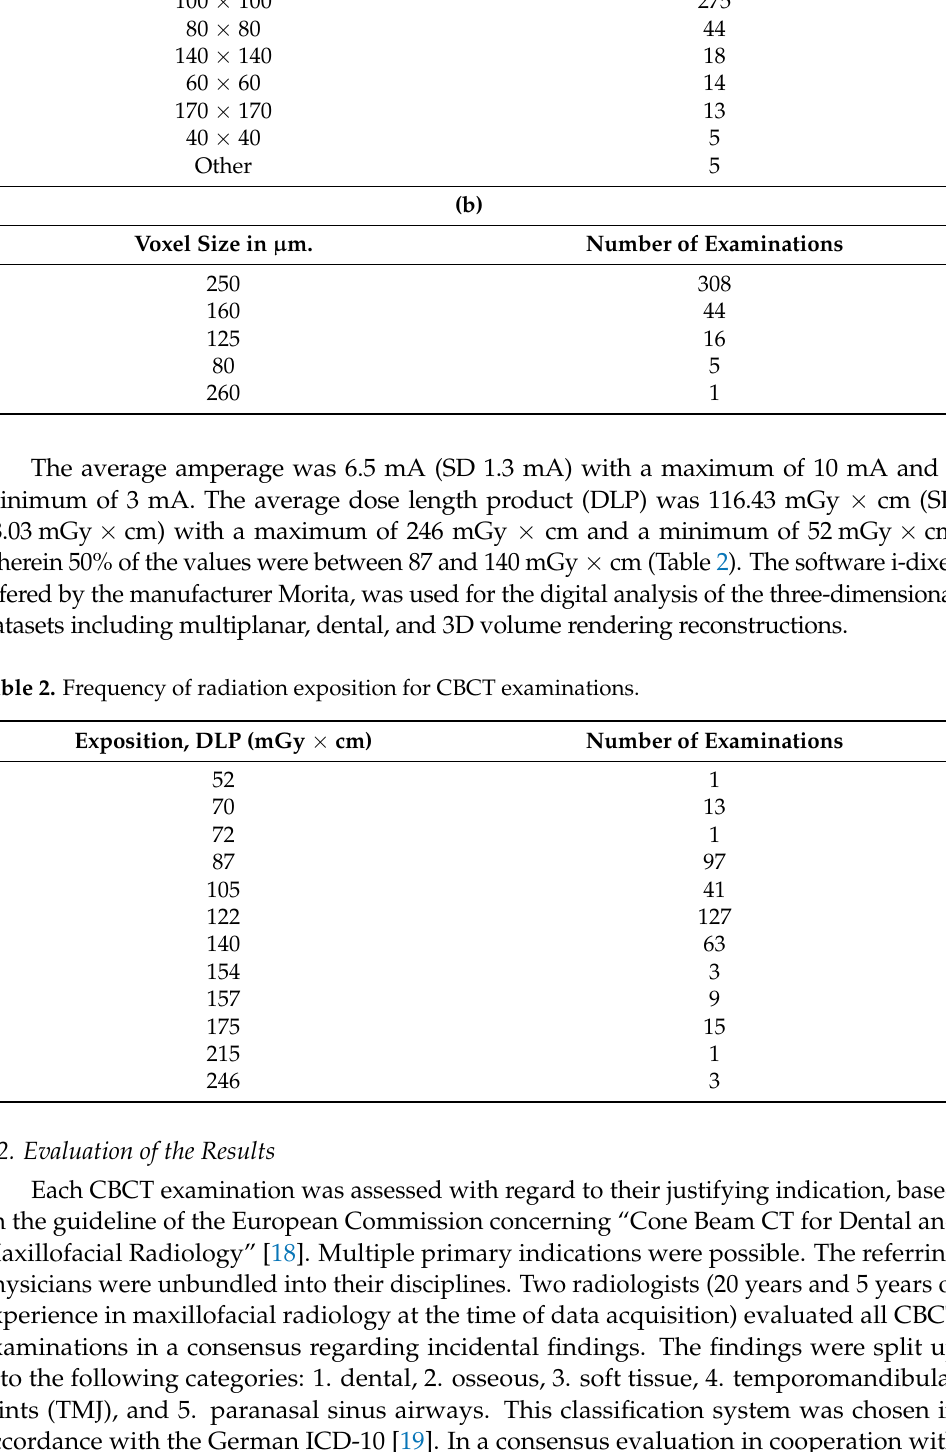
Voxel Size in µ m.